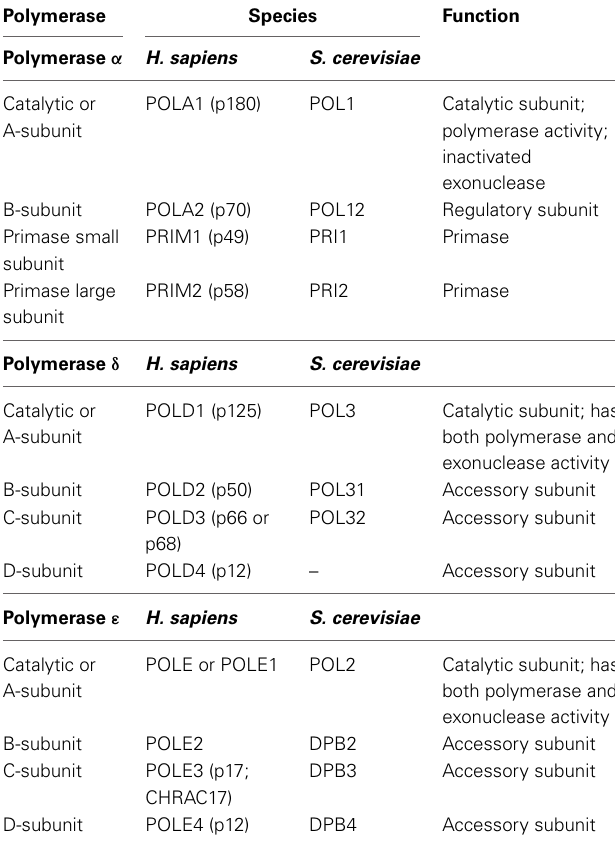
Table 1 | Eukaryotic DNA polymerases are multi-subunit enzymes.